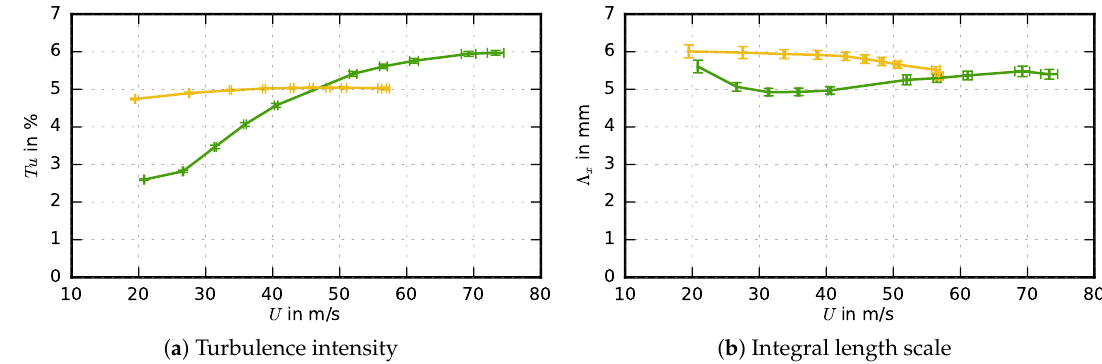
Figure 2. ( a ) Intensity and ( b ) integral length scale of the turbulence generated by the two perforated plates given in Table 1, measured at 30 points in a plane normal to the flow, at the position of the leading edge (given are the mean values as well as the standard deviations), PPS 12/2, PPS 14/4.